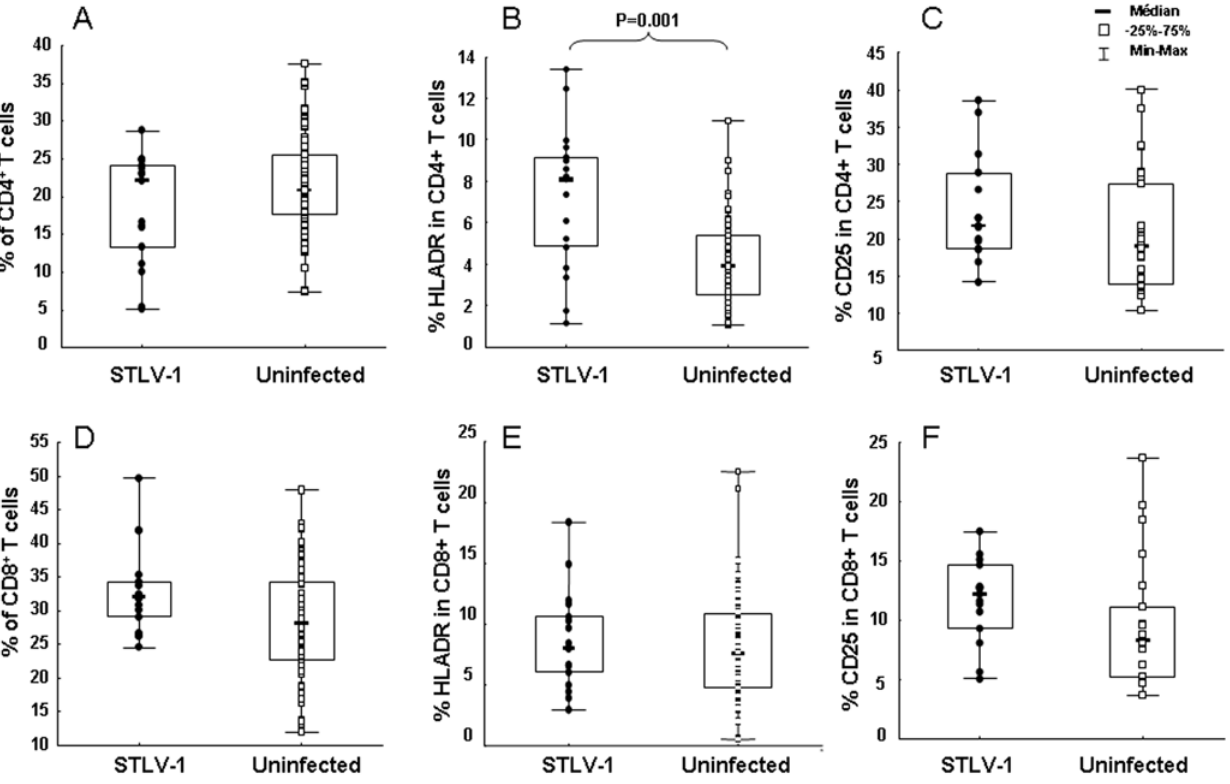
Figure 2. Comparisons of T-cell subsets in blood from 17 out of 19 mandrills infected with STLV ( N ) and 59 uninfected mandrills ( % ). (A) Percentages of CD3 + CD4 + cells. (B) Percentages of HLA-DR in CD4 + T cells. (C) Percentages of CD25 + in CD4 + T cells. (D) Percentages of CD3 + CD8 + cells. (E) Percentages of HLA-DR in CD8 + T cells. (F) Percentages of CD25 + in CD8 + T cells. Statistical analyses for each T-cell subset in the two groups of mandrills were performed with the Mann-Witney test. The only significant difference was in the percentage of HLADR in CD4 + T cells ( p =0.001).